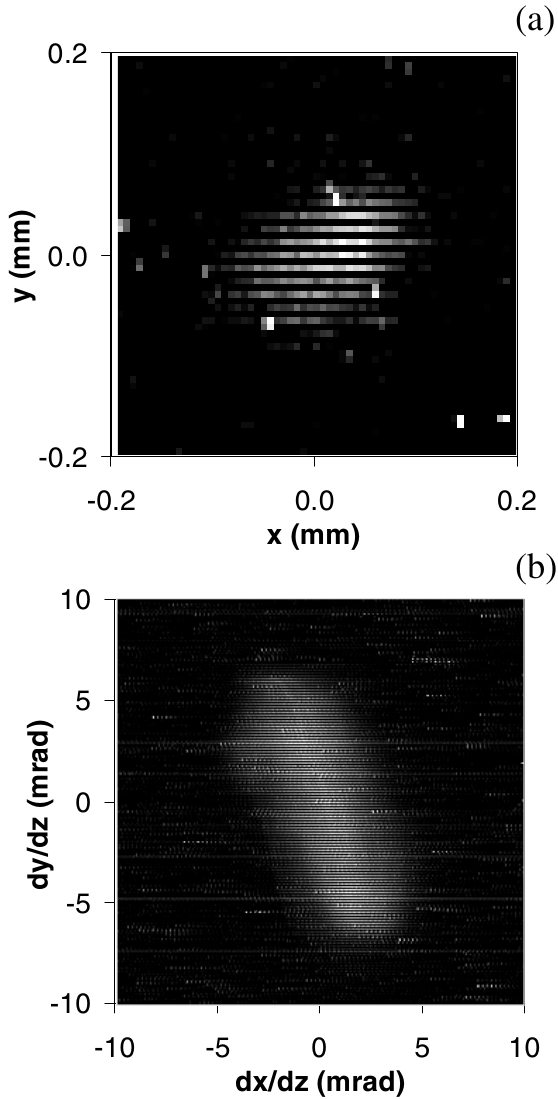
FIG. 3. Optical transition radiation image of the electron beam spot at the interaction (a), and an image from a YAG scintillator taken 0.8 m downstream of the interaction point used to determine the divergence of the electron beam